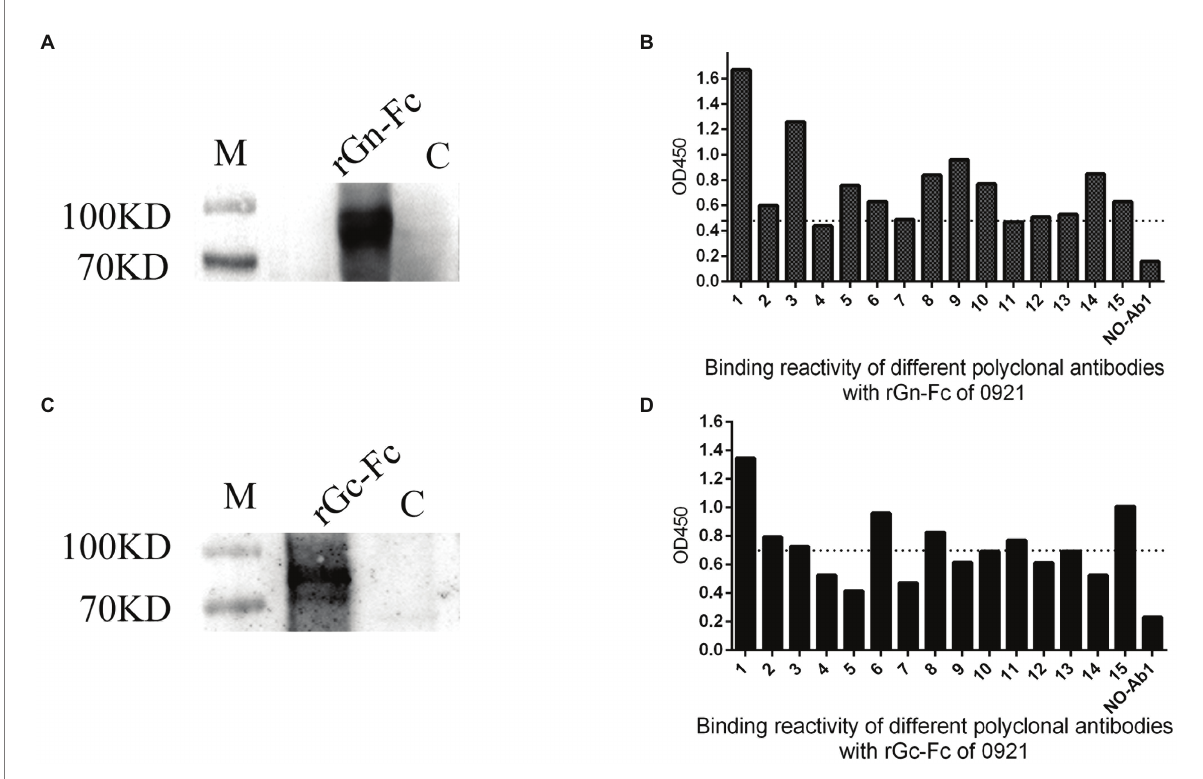
FIGURE 3 Cross reactivity of rGn-Fc/rGc-Fc of 0921 strain with different sera from SFTS donors. (A) rGn-Fc of 0921 strain by Western blot. The molecular weight of rGn-Fc is about 90KD. (B) Sera from SFTS donors reacted with rGn-Fc by ELISA. 15 sera were collected from donors in 2021. 14 of 15 sera reacted with rGn-Fc. The dotted line showed cut-off value. (C) rGc-Fc of 0921 strain by Western blot. The molecular weight of rGc-Fc is about 90KD. (D) Sera from SFTS donors reacted with rGc-Fc by ELISA. 9 of 15 sera reacted with rGc-Fc. The dotted line showed cut-off